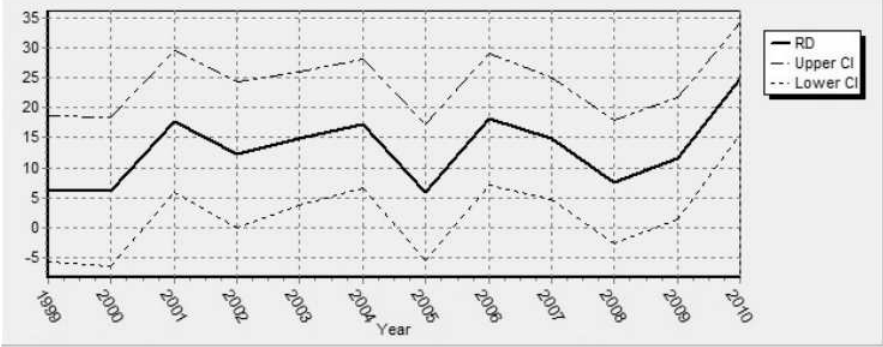
Figure 1. Trends of rate difference of age-standardised incidence rates among men in Świętokrzyskie, years 1999-2010